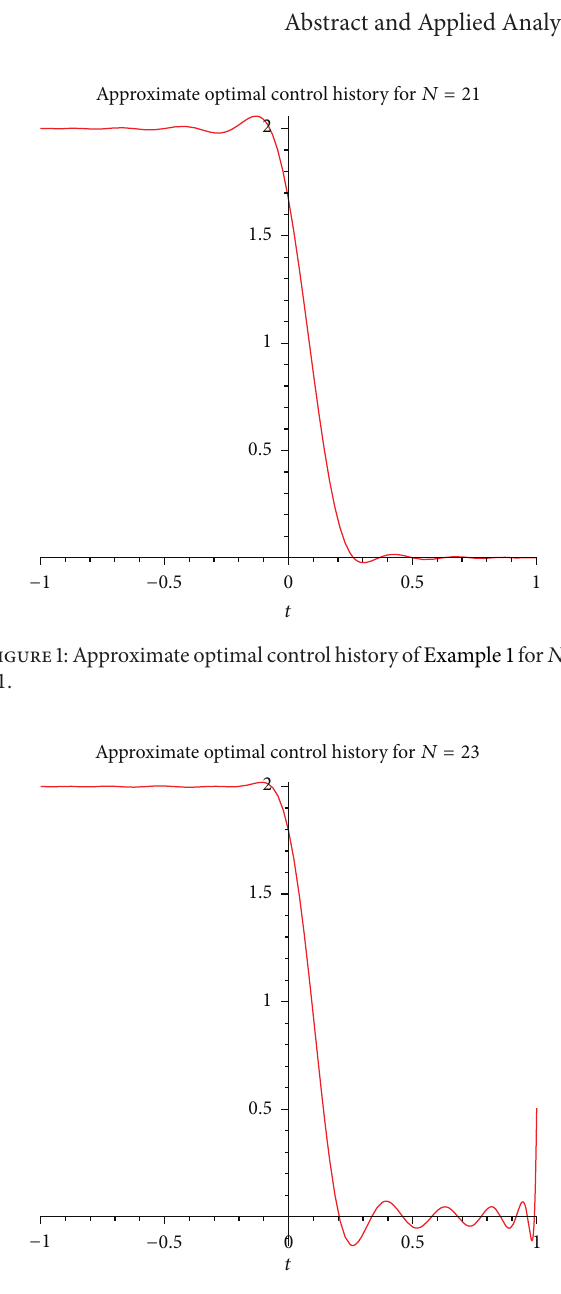
Figure2:ApproximateoptimalcontrolhistoryofExample 1for 𝑁 = 23 .